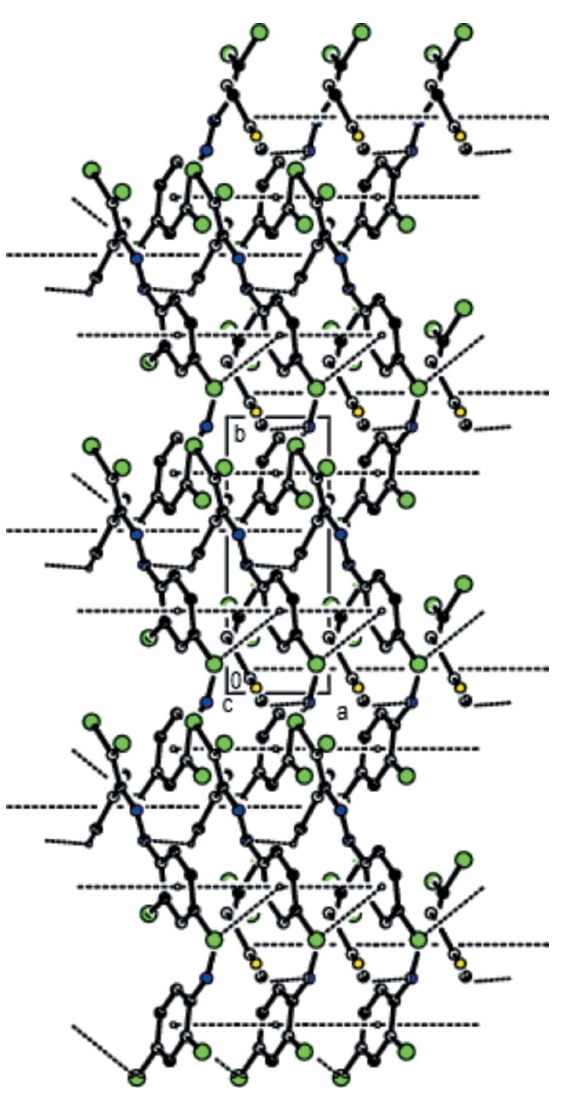
Figure 4 The crystal packing of the title compound viewed along the c axis with intermolecular C—H (cid:2)(cid:2)(cid:2) N and C—Cl (cid:2)(cid:2)(cid:2) (cid:2) interactions and (cid:2) - (cid:2) stacking interactions shown as dashed lines.